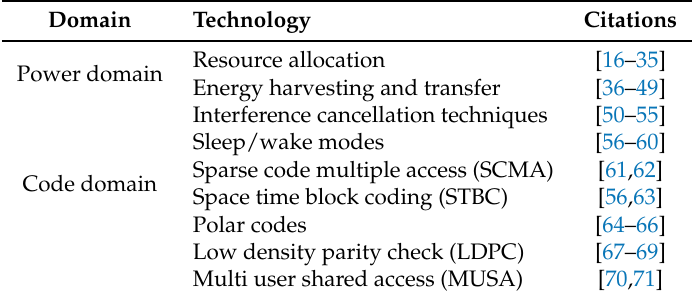
Table 1. Classification of research work related to energy efficient NOMA which are discussed in this article.